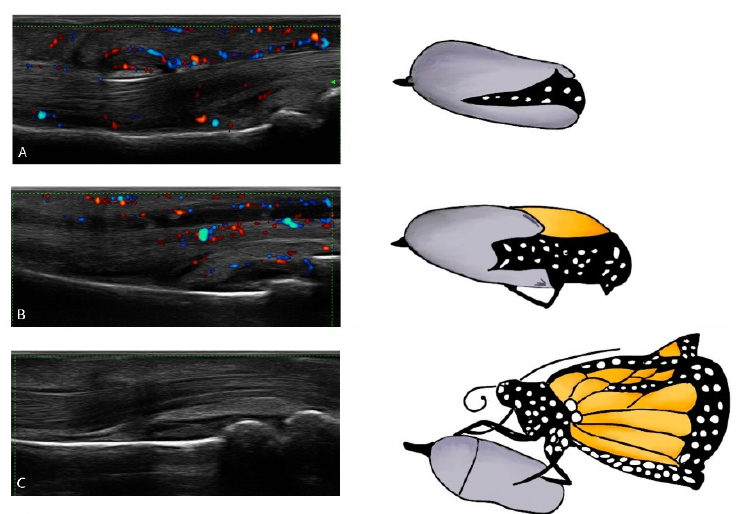
Figure 4. Evolution of dactylitis. Inflammation initially compromises the extracapsular structures and subsequently extends to the joint structures. The US lesions underlying dactylitis change over time, like evolving from a chrysalis to a butterfly. In particular: a) in the early phase flexor tenosynovitis and soft tissue oedema are prevalent. Joint synovitis is often absent; b) in the intermediate phase, both flexor tenosynovitis and synovitis may be present; c) in the late-chronic phase, joint synovitis is prevalent while flexor tenosynovitis is often absent or present but of minimal